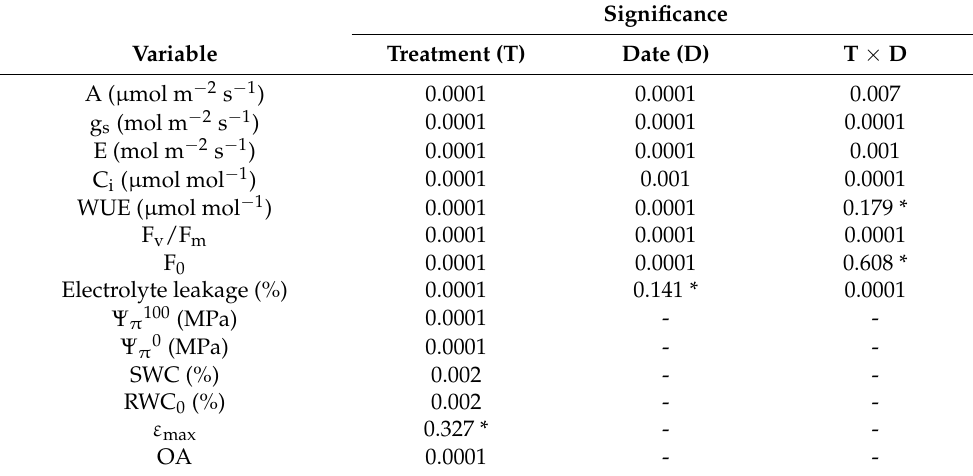
Table 1. Significance levels of treatment effects (T), date effects (D) and their interaction (T × D).